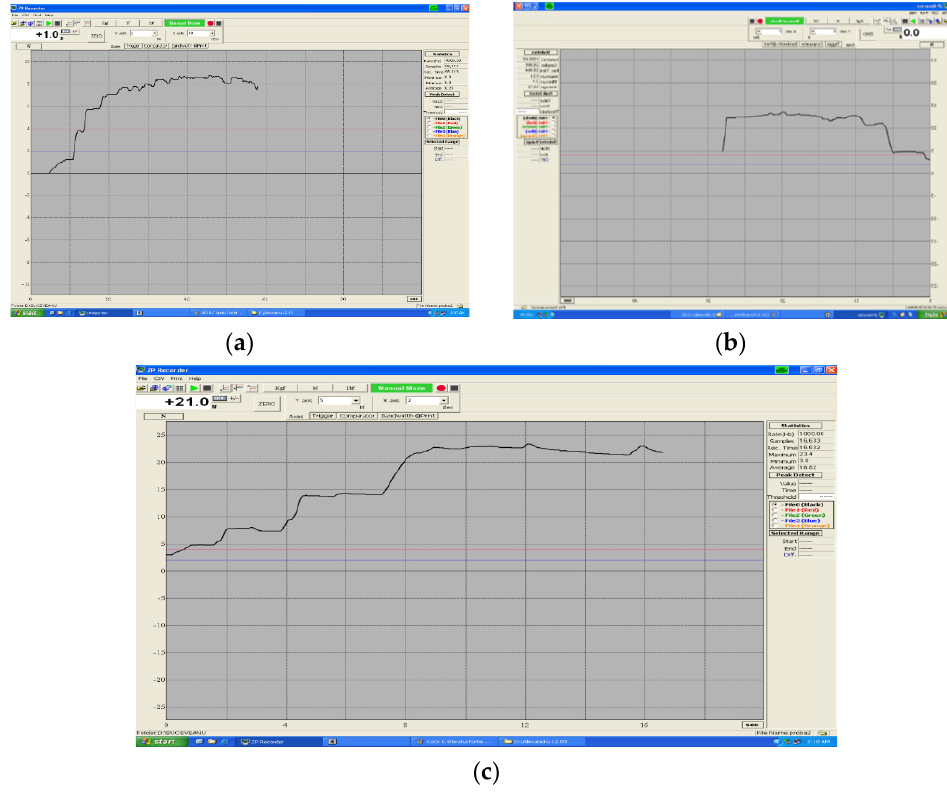
Figure 10. ( a – c ) Evolution of Cr-Co spring forces, diameter 0.9 mm. For the 1.2 mm Ni-Cr wire, the changes are shown in Table 5. Table 5. Results for Ni-Cr 1.2 mm arches.